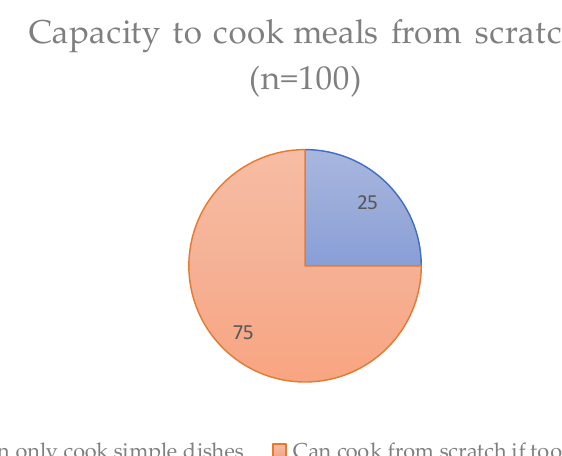
Figure 4. Degree of confidence in ability to cook a wide variety of meals from scratch.